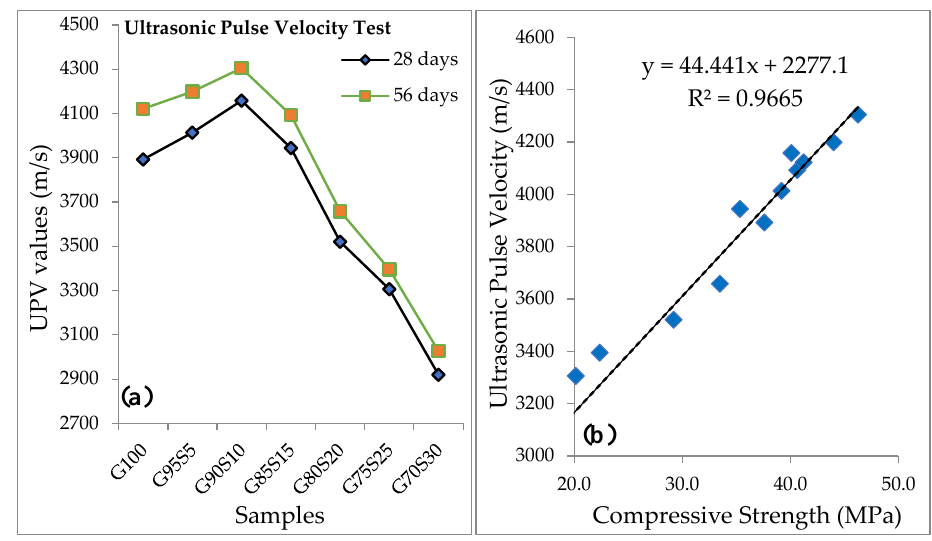
Figure 3. ( a ) UPV test results; ( b ) correlation of compressive strength with UPV values.